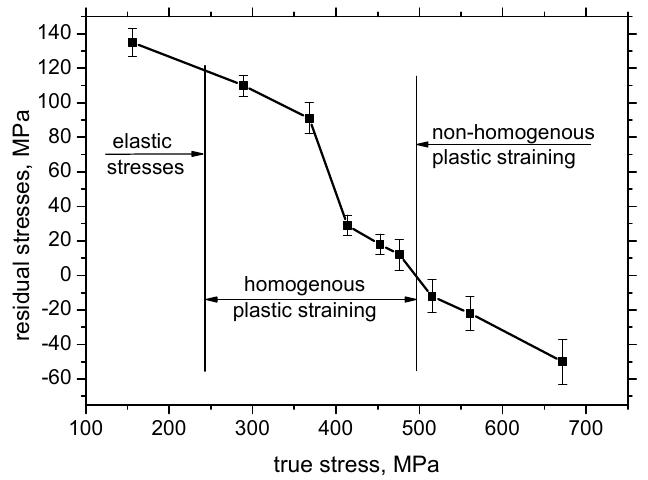
Figure 9. Evolution of residual stresses for the different ε , RD.